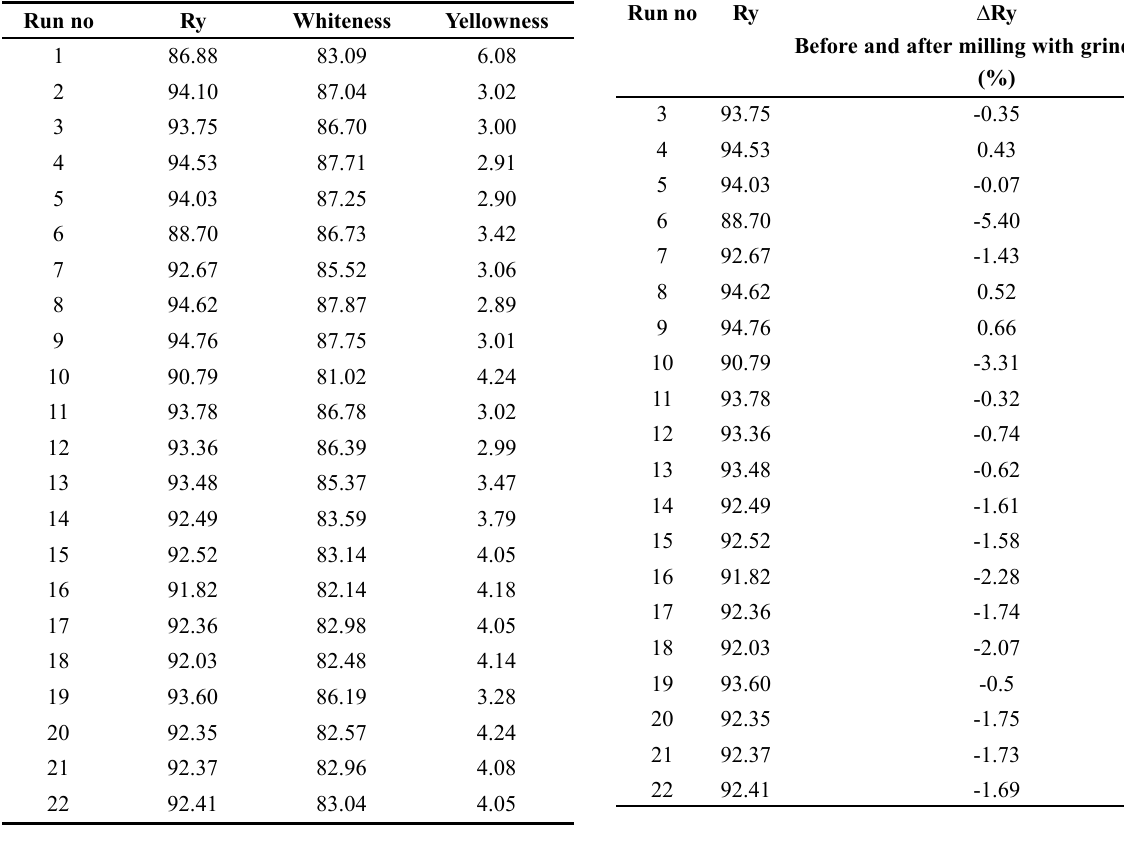
Table 6. Colour properties (Ry, whiteness and yellowness) of the feed sample and products